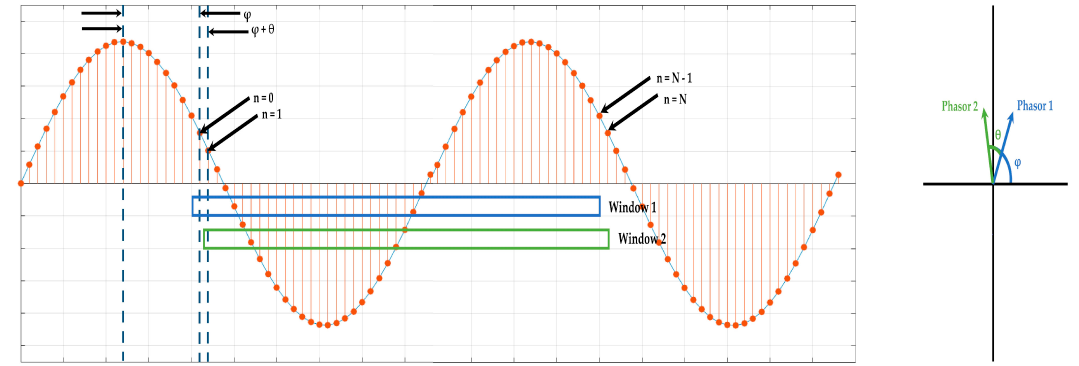
Figure 6. Non-recursive method of updating